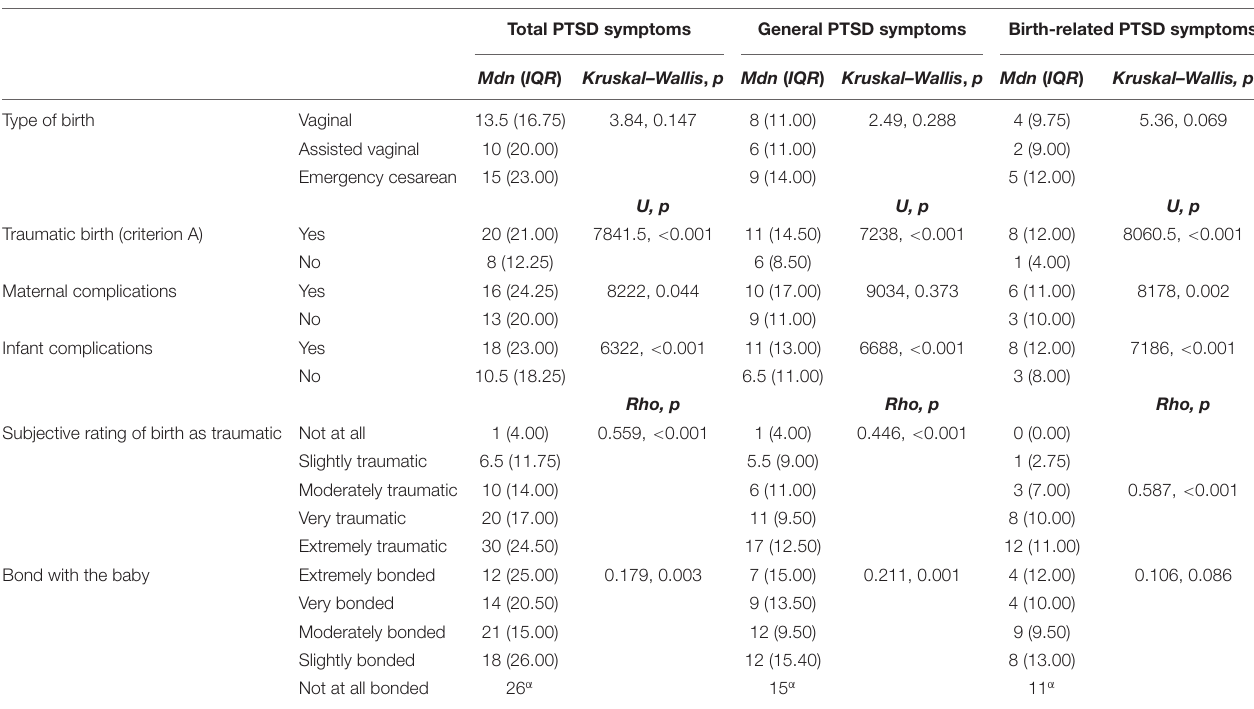
TABLE 7 | Known group